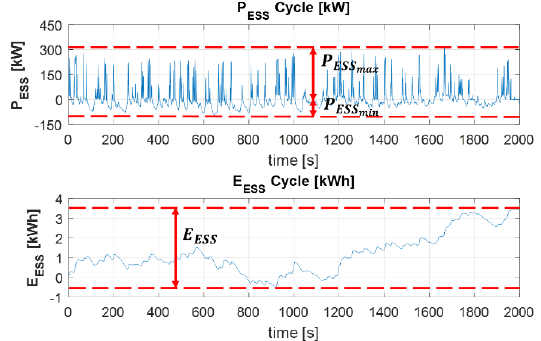
Figure 8. Scheme of an example of the ESS energy storage calculation.